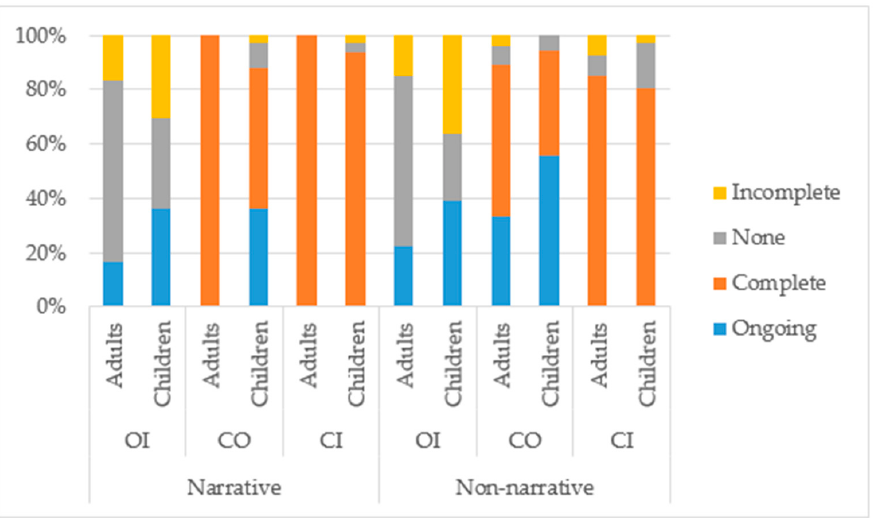
Figure 4. Picture choice for PI for the three different conditions (C–O, C–I, O–I) in the narrative and non-narrative settings.